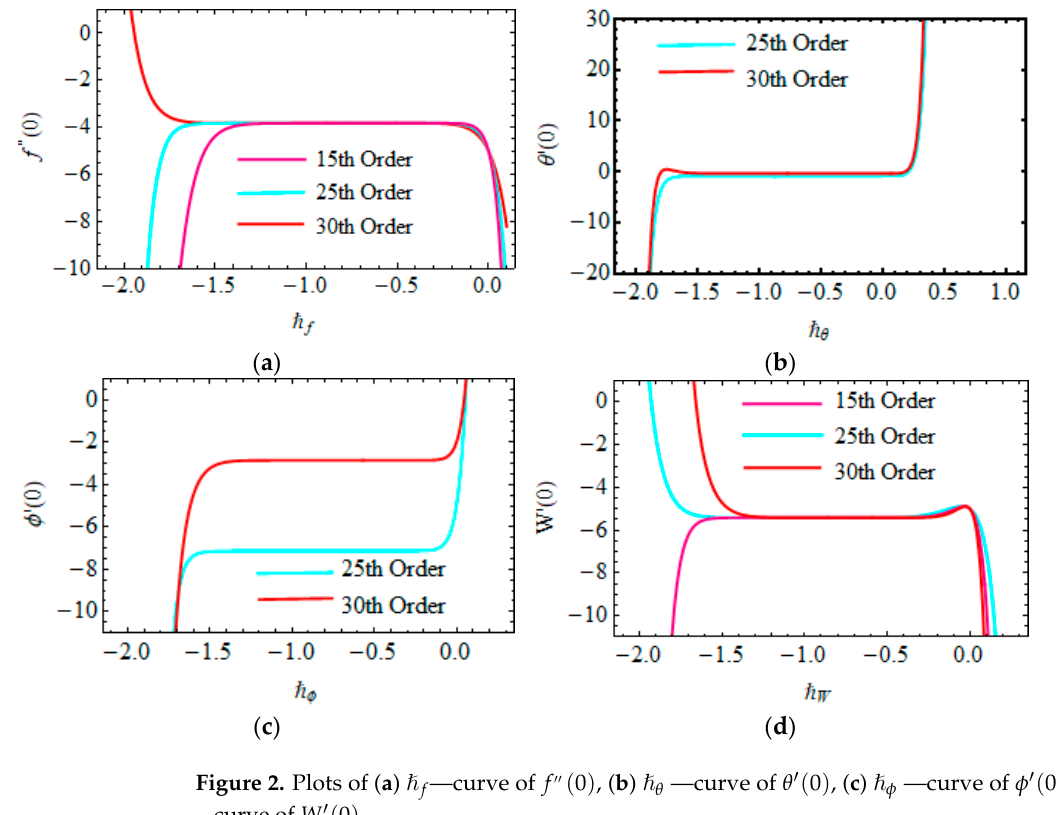
Figure 2. Plots of ( a ) (cid:125) f —curve of f (cid:48)(cid:48) ( 0 ) , ( b ) (cid:125) θ —curve of θ (cid:48) ( 0 ) , ( c ) (cid:125) φ —curve of φ (cid:48) ( 0 ) and ( d ) (cid:125) w —curve of W (cid:48) ( 0 ) .